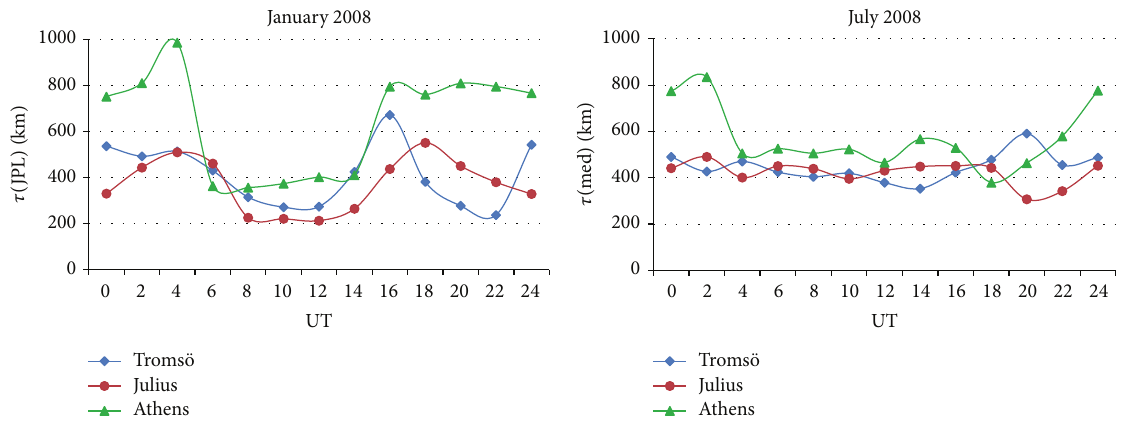
Figure 9: Illustration of differences of 𝜏 for stations with different latitudes.